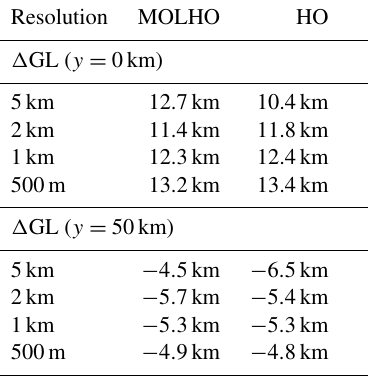
Table 4. Displacements of the grounding line ( (cid:49) GL) at the end of the perturbation phase (P75S) obtained with MOLHO and HO mod- els.